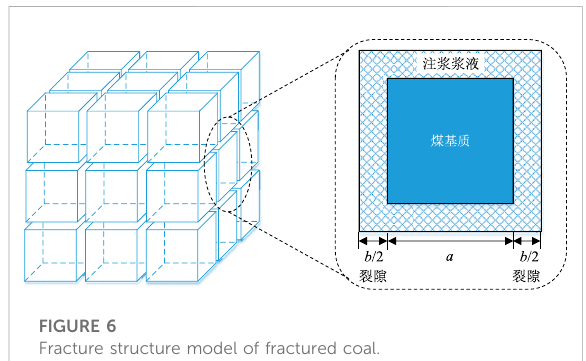
FIGURE 6 Fracture structure model of fractured coal.